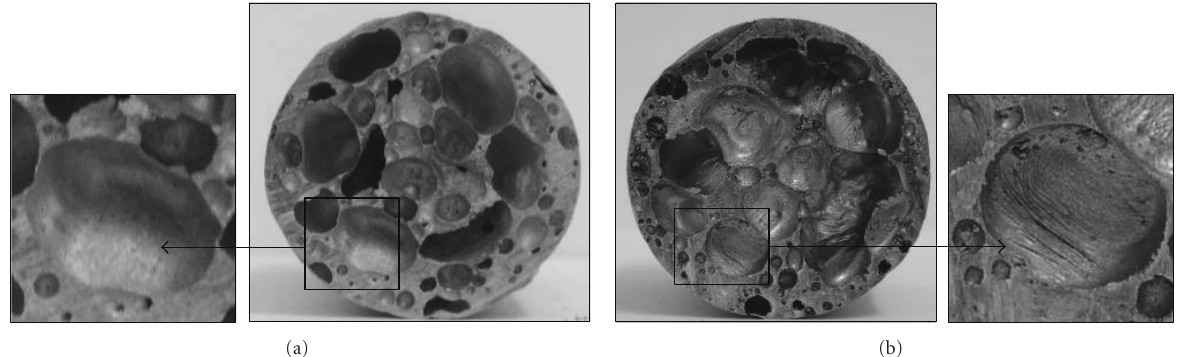
Figure 13: Corrugated cell walls due to di ff erent foaming gas (BM, suction): (a) nitrogen and (b) air.